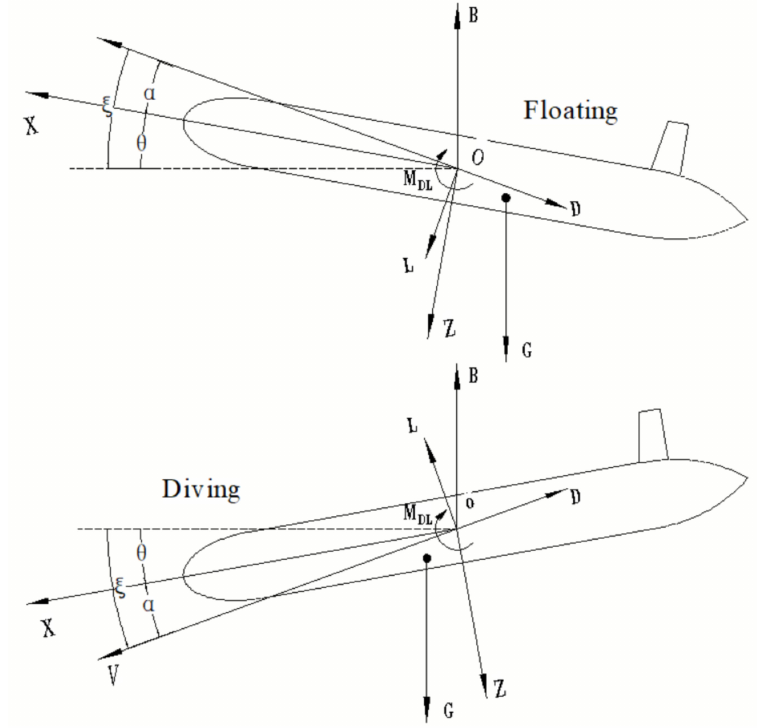
Figure 3. Steady state of the glider during diving and